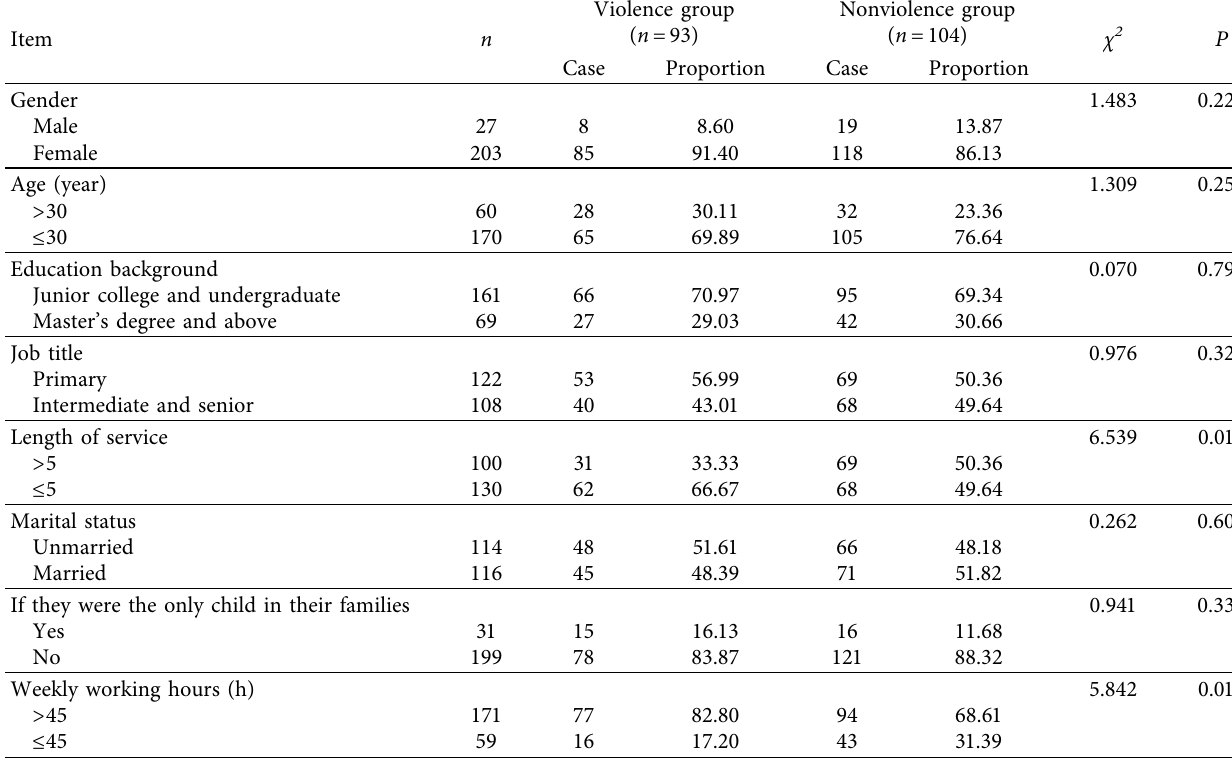
Table 3: Univariate analysis of the influencing factors of workplace violence that ICU medical staff